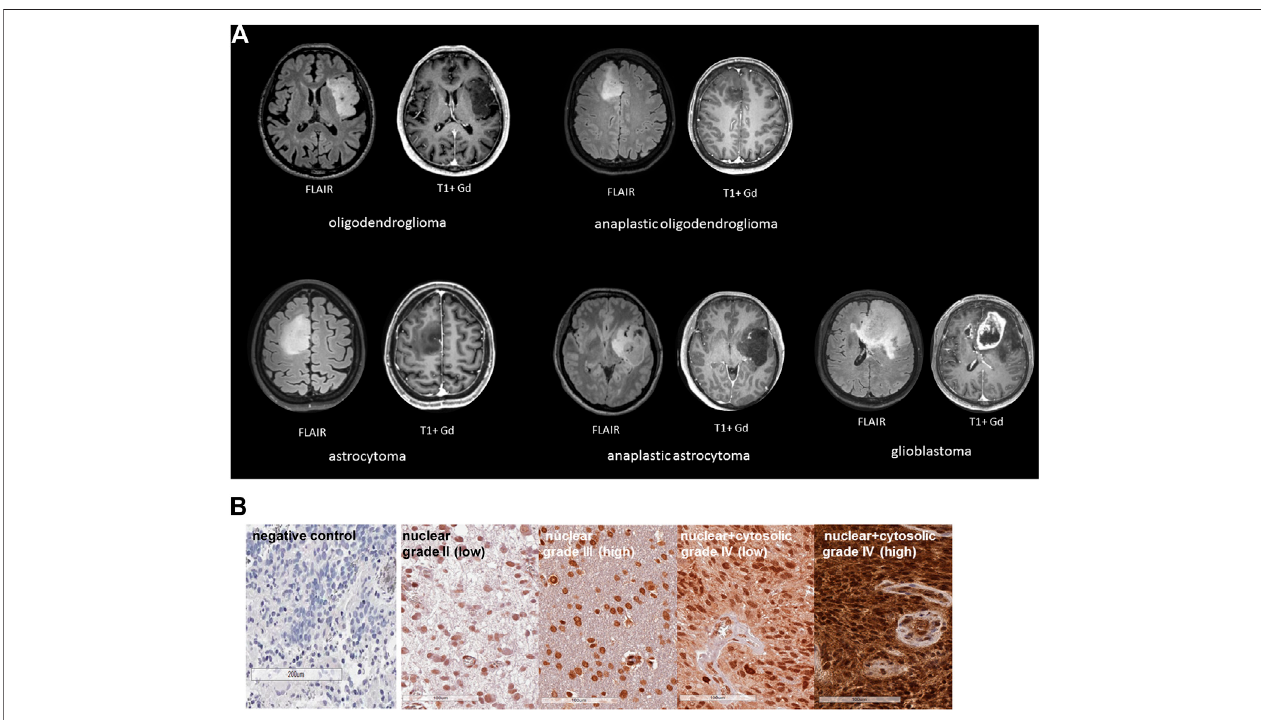
FIGURE 1 | (A) Representative MR images of different glioma grades: oligodendroglioma, astrocytoma (grade II), anaplastic oligodendroglioma, anaplastic astrocytoma (grade III), glioblastoma (grade IV). Left, FLAIR images, right, T1 images with Gadolinium (Gd). (B) Representative immunohistochemical (IHC) stainings of Hsp70 in control tissue and tumor sections (3 µm) of grade II, III and IV gliomas. Shown are comparisons of nuclear vs. nuclear + cytosolic stainings patterns with low or high Hsp70 staining intensity.